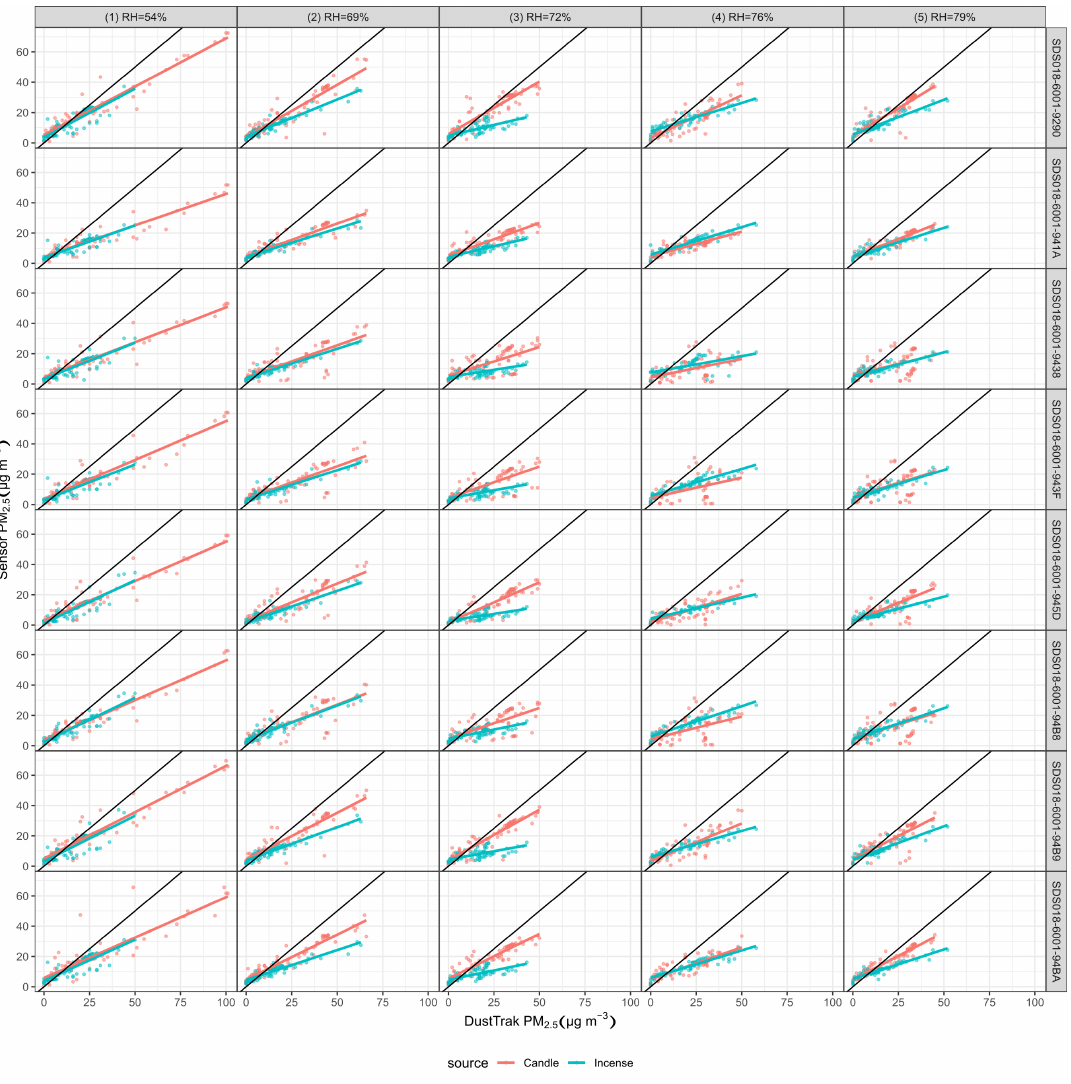
Figure A5. Comparison and linear regression of the Alphasense OPC-R1 with the DustTrak (x = DustTrak, y = sensors) during the five experiments for peaks and stable concentrations of PM generated using incense and candle. The black line is x =